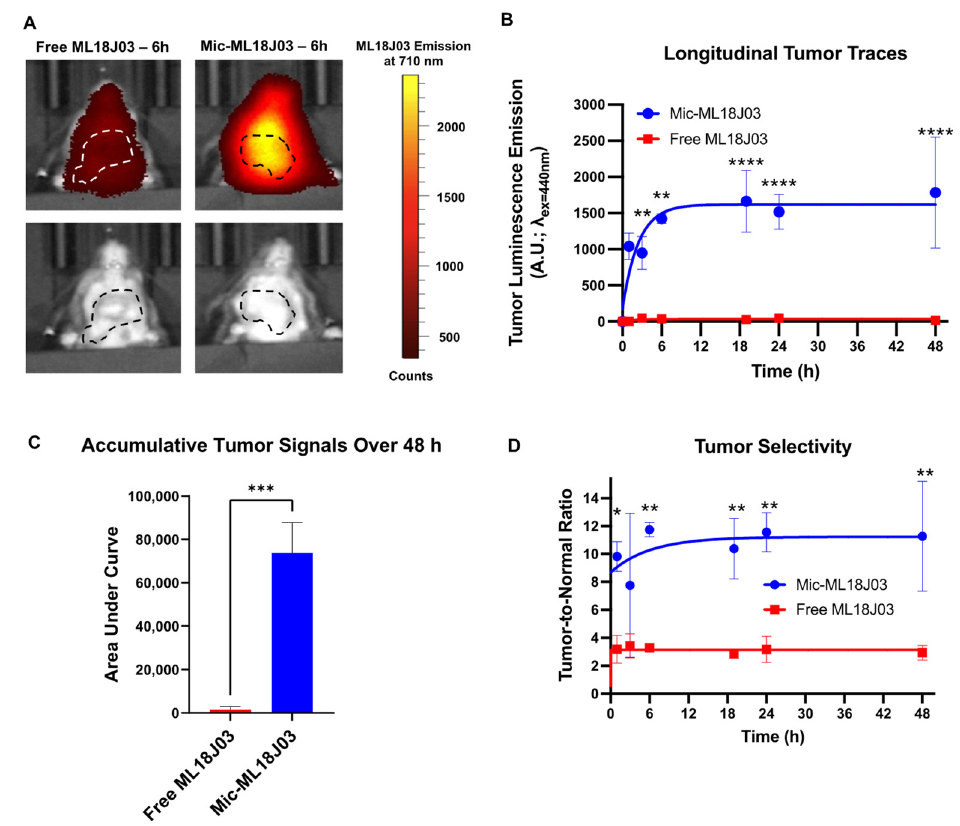
Figure 5. ( A ) Representative images of orthotopic in vivo AT-84 tumors in C3H/HeJ mice 6 h following intravenous administration of free ML18J03 or Mic-ML18J03 (30 mg/kg); ( λ Exc = 440 nm, λ Emi = 710 nm). Quantification of the longitudinal ( B ) and accumulative ( C ) in vivo luminescence emission signals of free ML18J03 or Mic-ML18J03 up to 48 h following administration. ( D ) Tumor selectivity of free ML18J03 or Mic-ML18J03 with respect to nearby healthy tissue. (All luminescence emission signals have been corrected for tissue autofluorescence for each respective animal. All of the data is mean ± standard deviation; statistical significance was calculated using a One-Way ANOVA test ( A , D ) and a two-tailed t -test ( D ). *: p ≤ 0.05, **: p ≤ 0.001, ***: p ≤ 0.001, ****: p ≤ 0.0001).